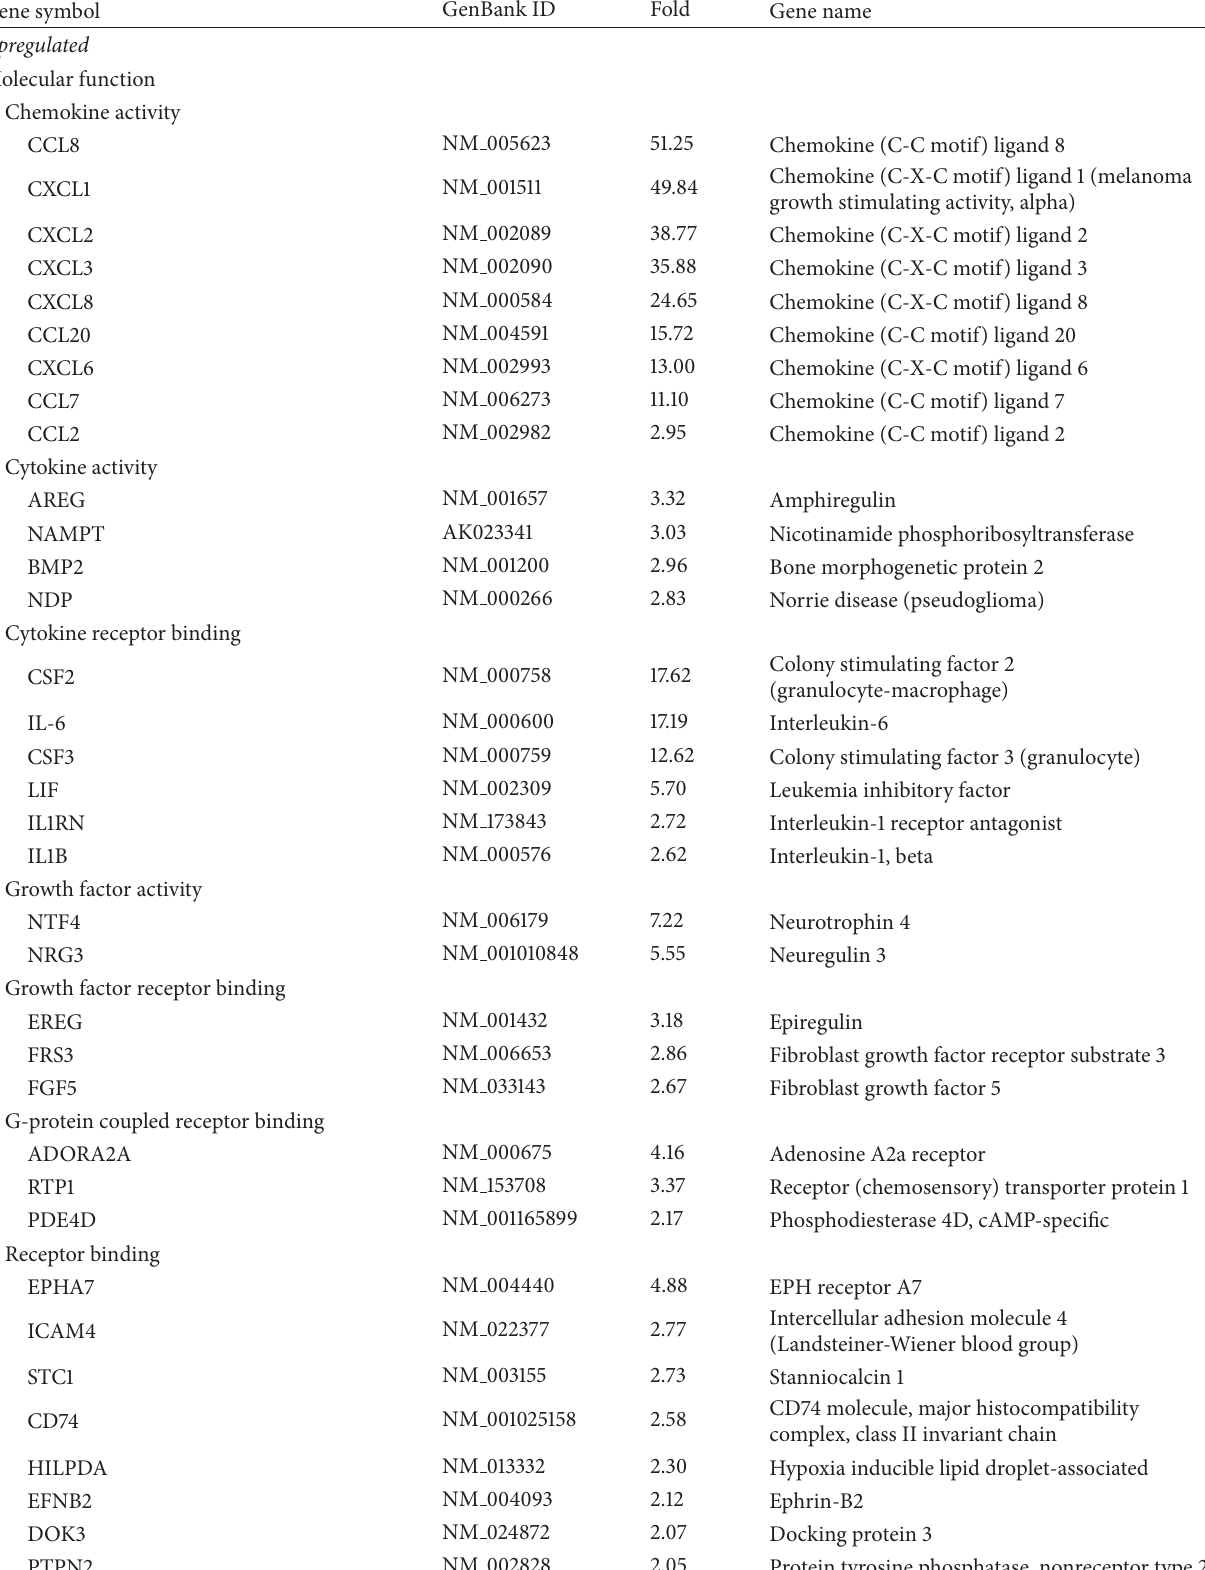
Table 2: IL-17-responsive genes in synovial fibroblasts form